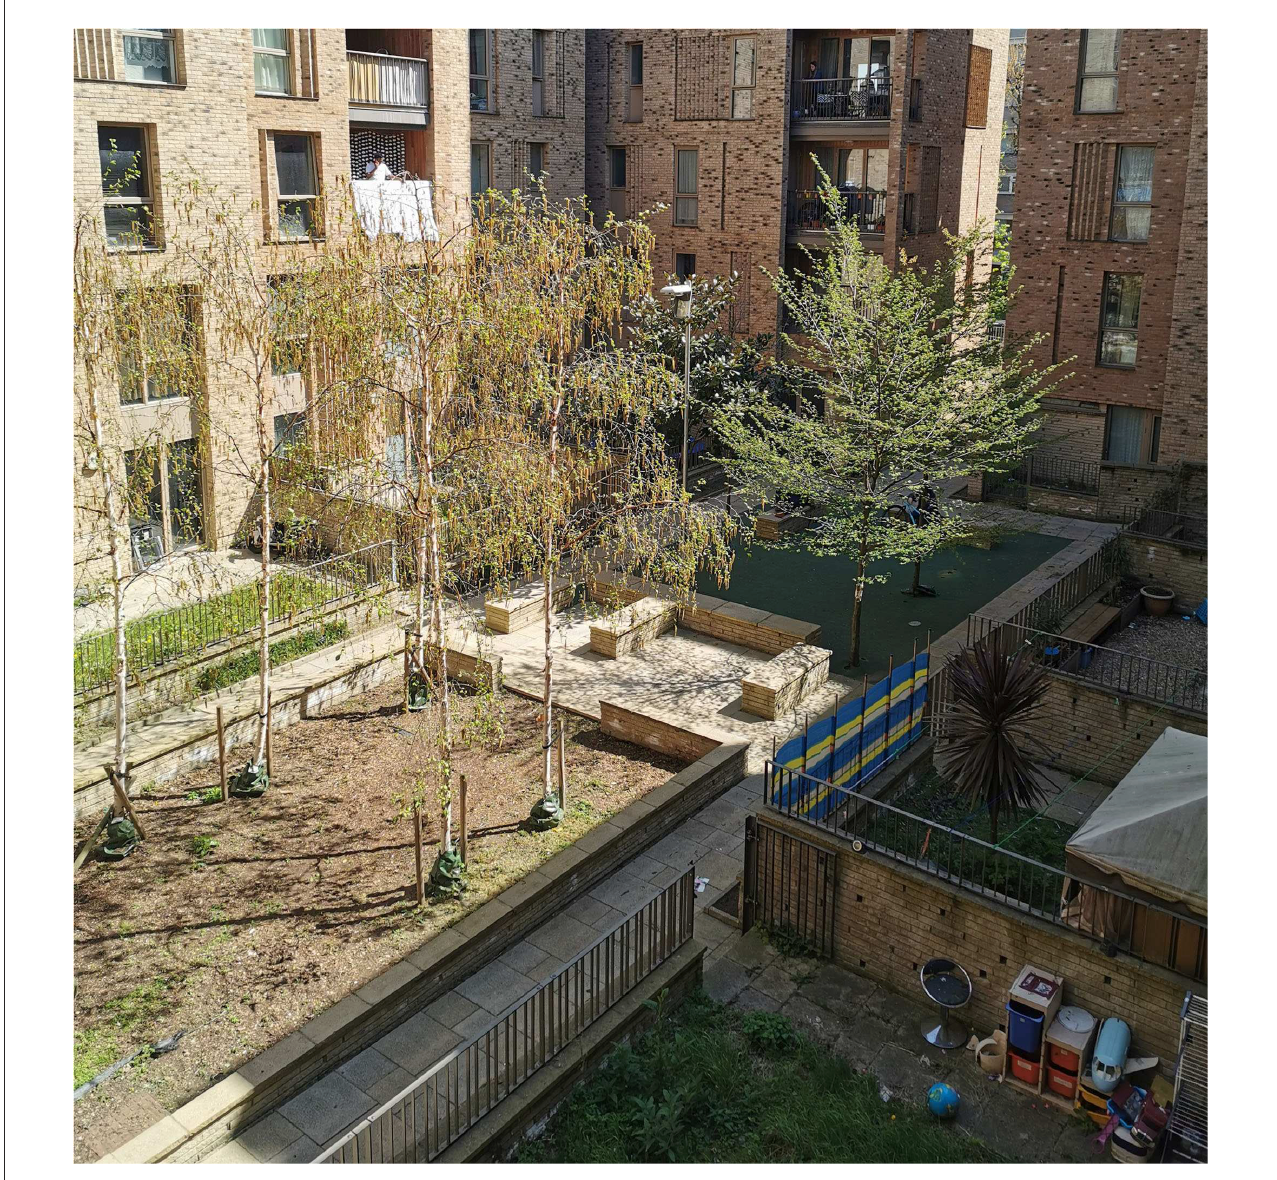
FIGURE9 View of central courtyard at Royal